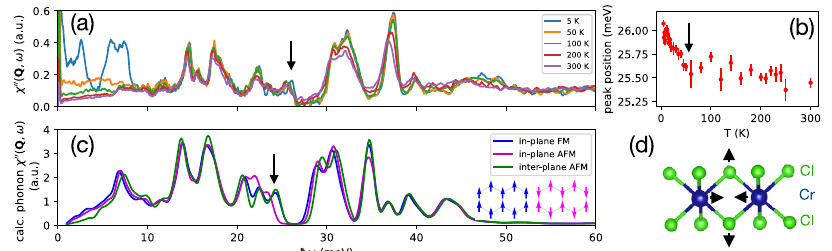
Fig. 2 Phonons. a A plot of the dynamic susceptibility, χ 00 Q ; ω ð Þ as a function of temperature along the high- Q trajectory. Intensities have been smoothed; for clarity, error bars not shown. b Position of the 26 meV phonon feature from fi tting. Error bars represent one standard deviation. c DFT-calculated phonon intensity along the high- Q trajectory for the R 3 structure with spins fi xed to a certain ordering, including FM, in-plane AFM, or the inter-plane AFM observed in CrCl 3 . Inset depicts in-plane FM or AFM alignment. The features in the DFT intensity are about 7% lower in (cid:1) h ω than the corresponding features in ( a ). d Atomic movement of the 26 meV phonon